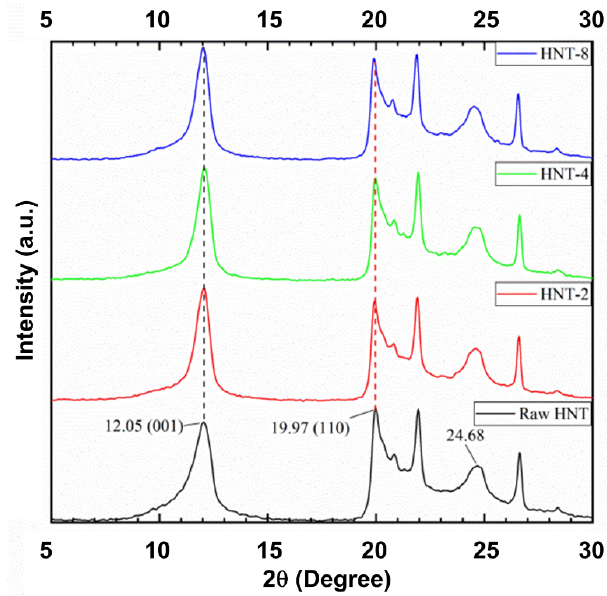
Figure 5. XRD scattering patterns of HNT after various durations of acid treatment.